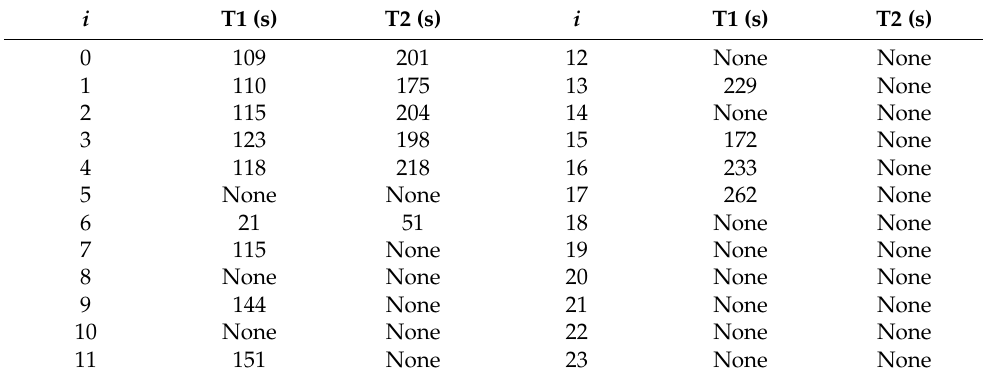
Table 3. Dynamic change data of the cruise ship risk level under fire